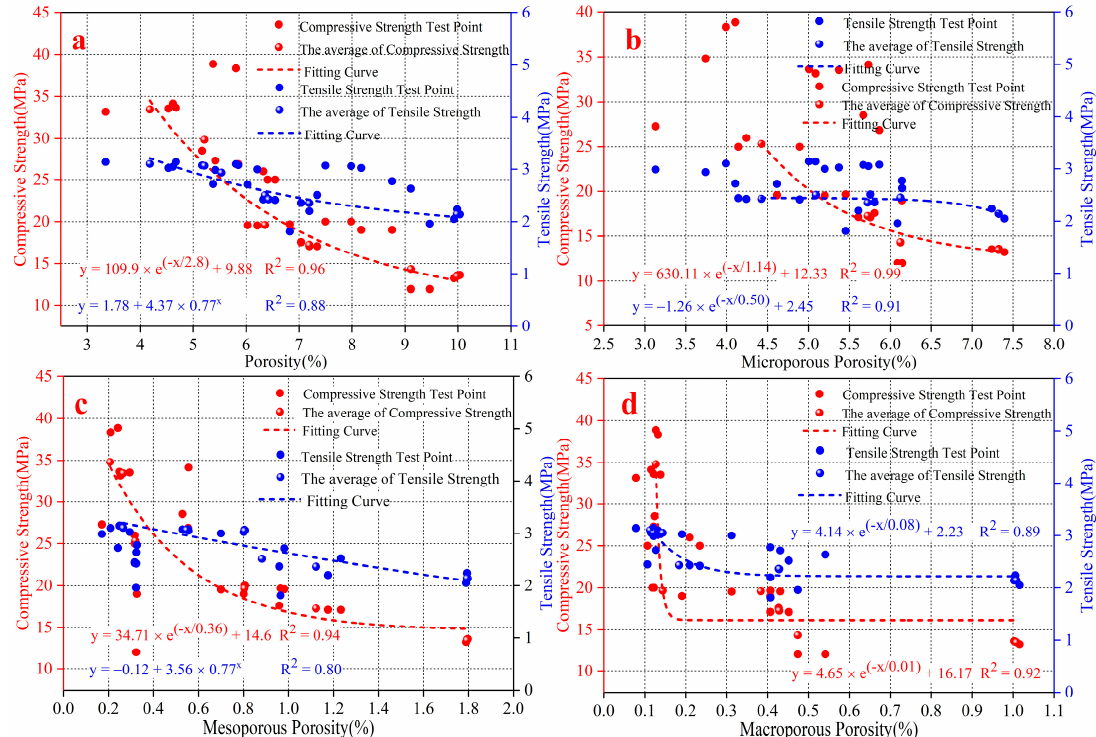
Figure 9. Fitting analysis of different porosity parameters and mechanical properties. ( a ) is the fitting analysis of porosity and mechanical properties. ( b ) is the fitting analysis of microporosity and mechanical properties. ( c ) is the fitting analysis of mesoporosity and mechanical properties. ( d ) is the fitting analysis of macroporosity and mechanical properties.